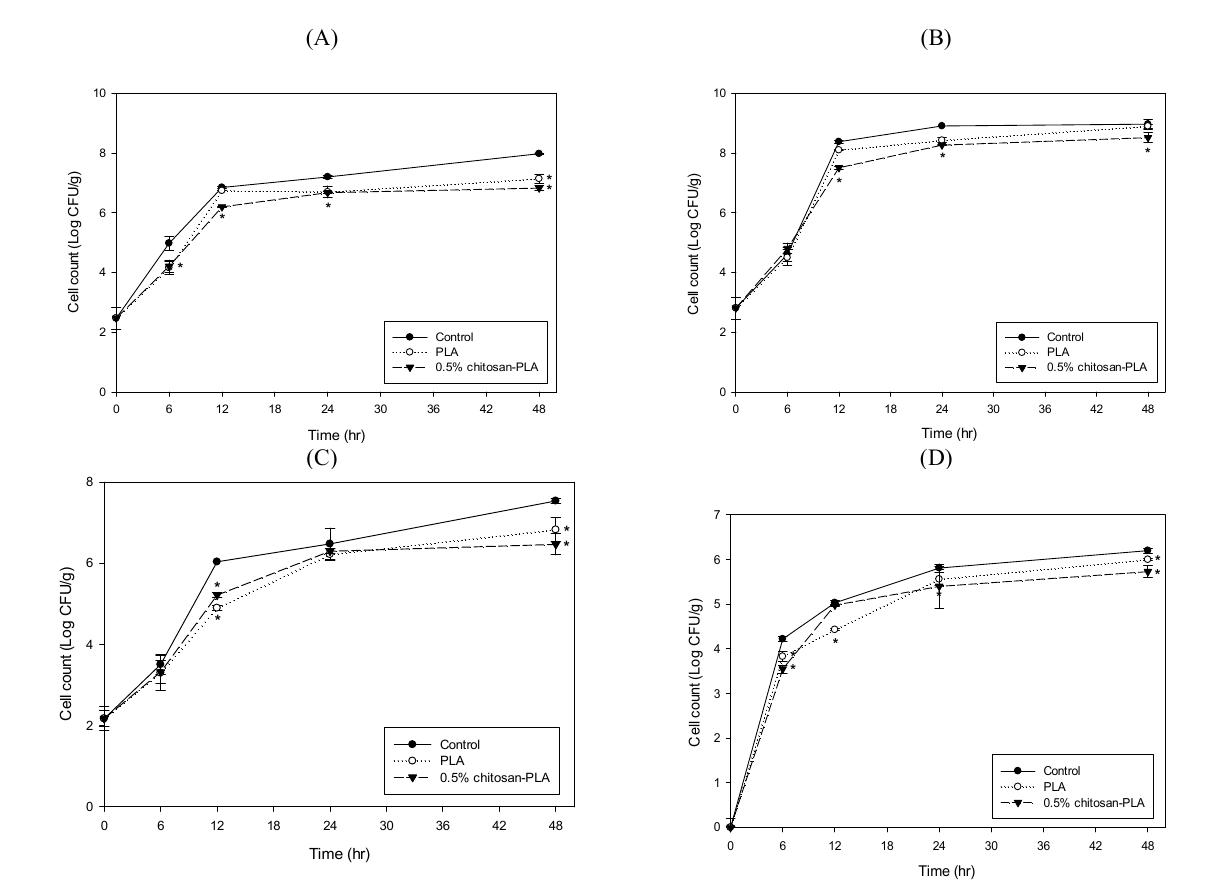
Figure 4. Changes in cell counts of coliforms ( A ); Aeromonas ( B ); Pseudomonas ( C ); and Vibrio ( D ) groups in fish fillet ( Epinephelus fuscoguttatus x Epinephelus lanceolatus ) uncovered (control) or covered with PLA or 0.5% CH–PLA film during storage at 25 °C. Data are presented as mean ± SD ( n = 3). * significantly different compared to control ( p < 0.05)